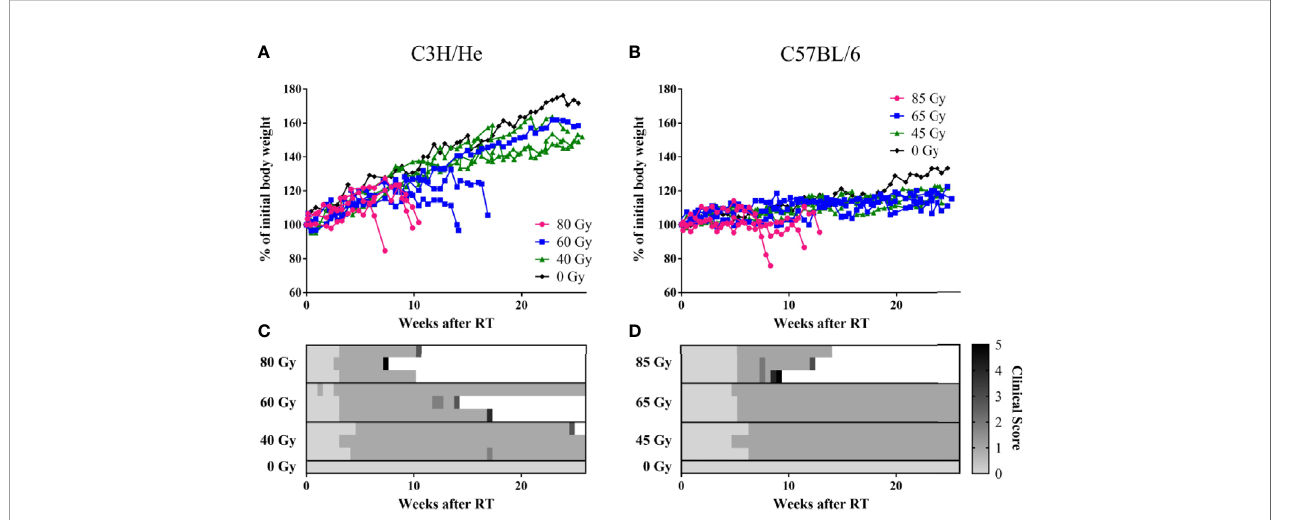
FIGURE 3 | Weight curves of (A) C3H/He and (B) C57BL/6 shown as percent of initial body weight. (C, D) General health scoring of mice included skin reaction (grade 0 – 4), body weight reduction, general appearance, and behavior, according to a fi xed set of criteria. A combined score of 5 was set as the stopping